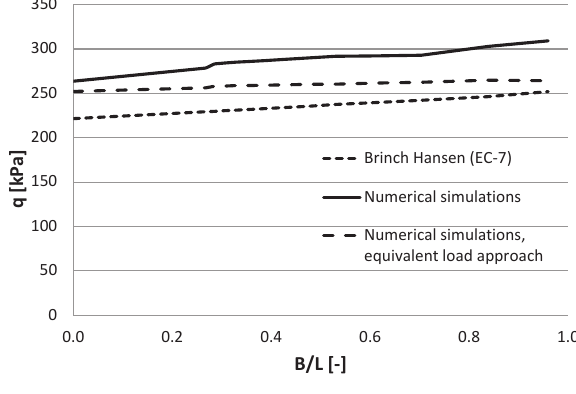
Figure 11: Obtained values of ultimate load as a function of B/L ratio.